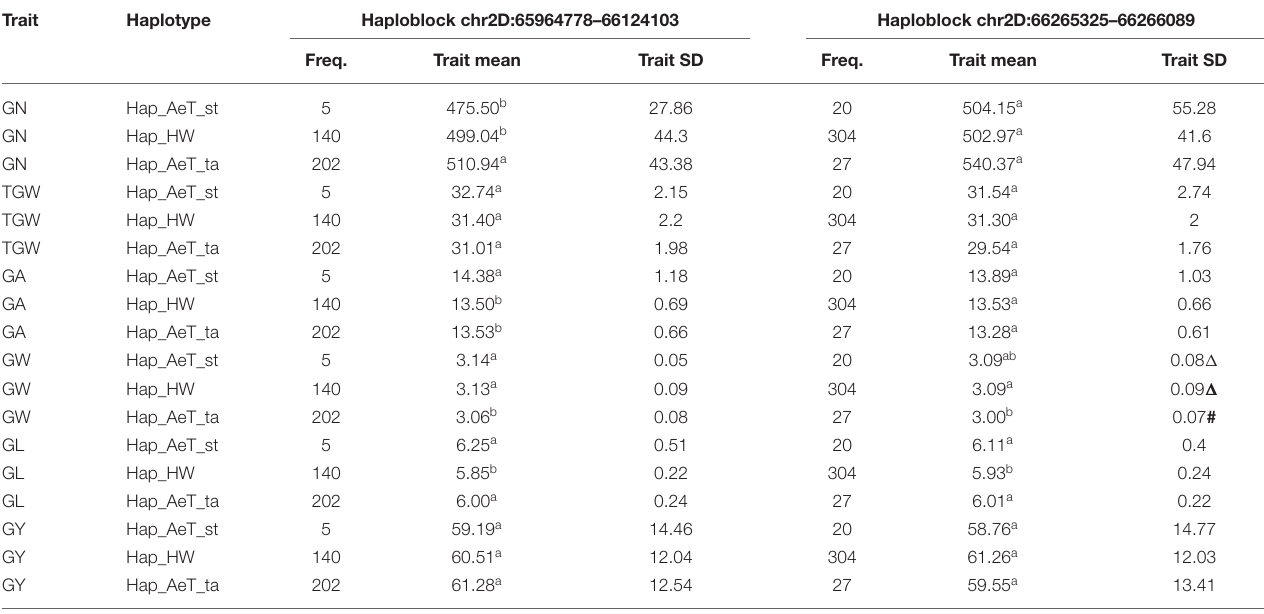
TABLE 6 | Chromosome 2D haplotypes variants associated with the grain width (GW) in Colby 2018 rainfed trial and their effects on other traits in the introgression population. Trait Haplotype